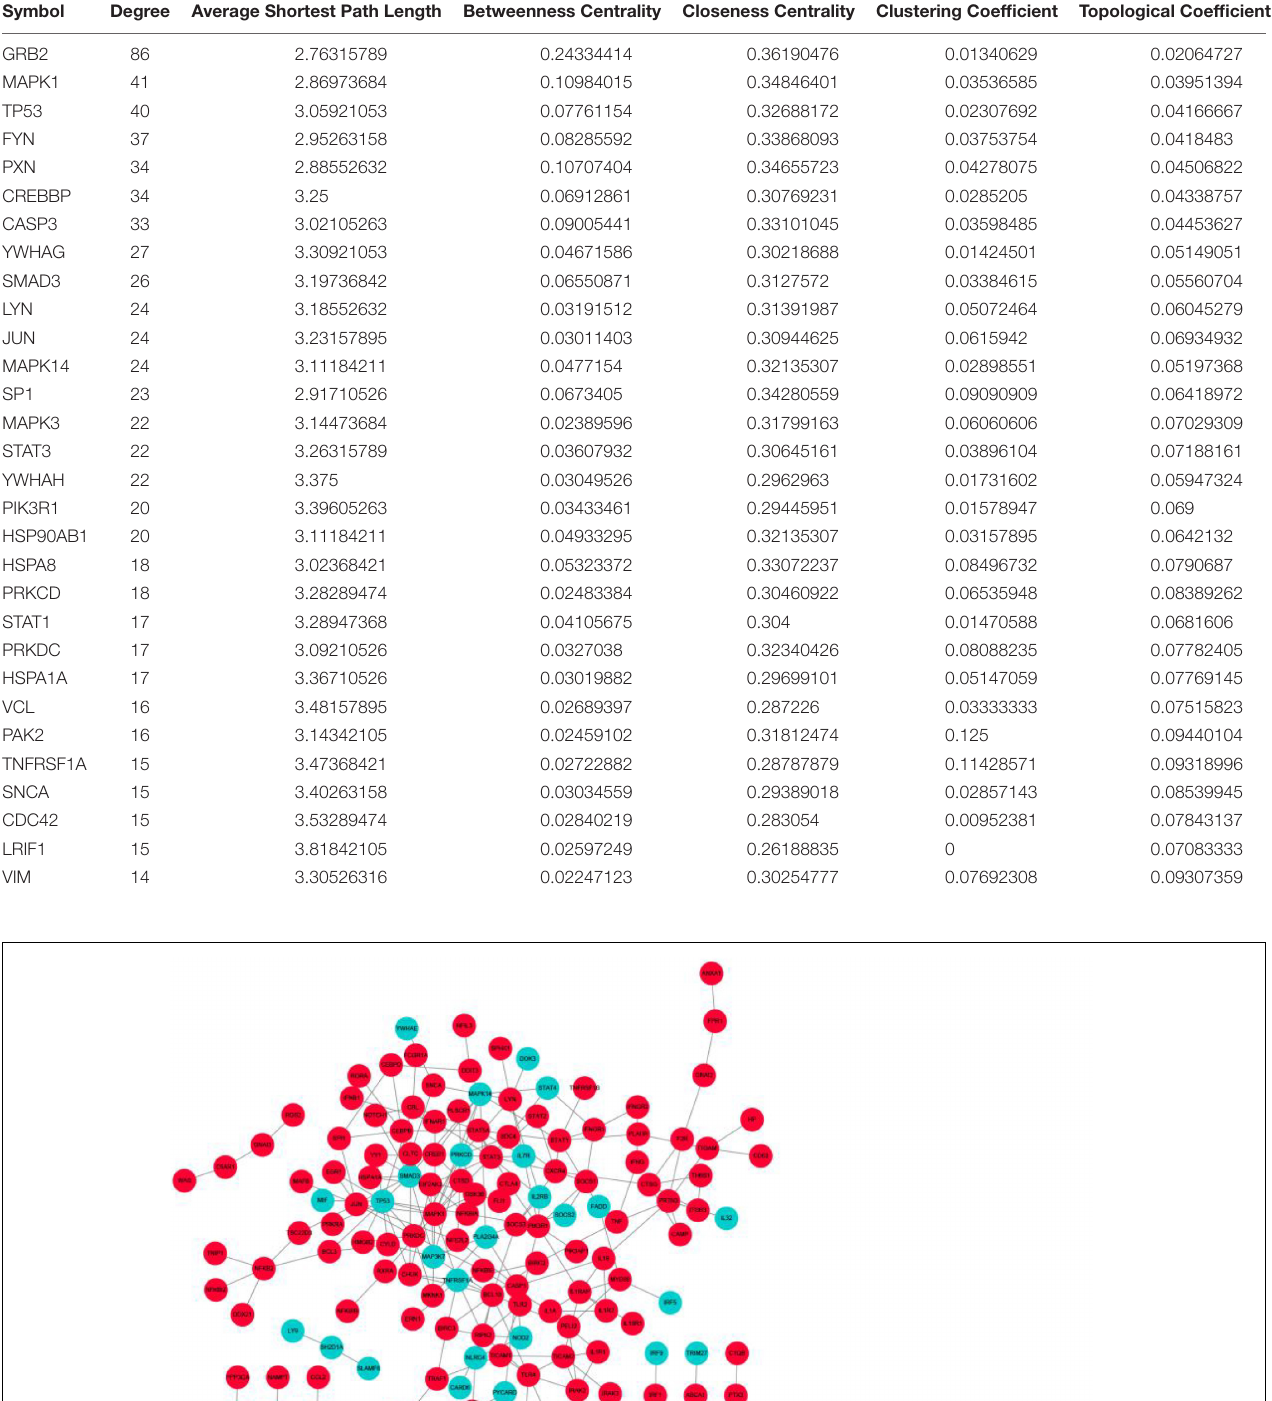
TABLE 1 | Top 30 ranked genes in the PPI network of integrated DEGs.